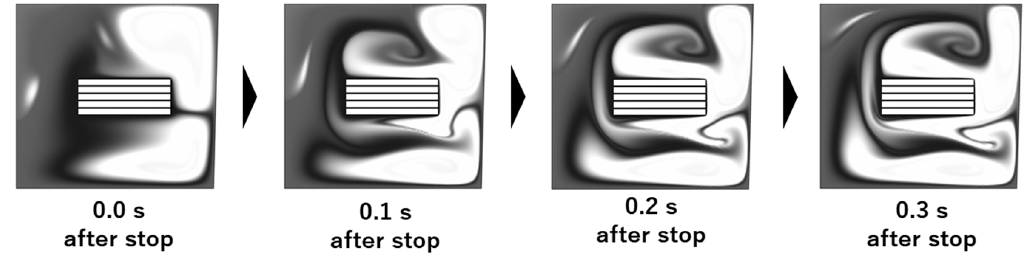
Figure 8. Calculated image of variation in concentration distributions after stopping the flow.